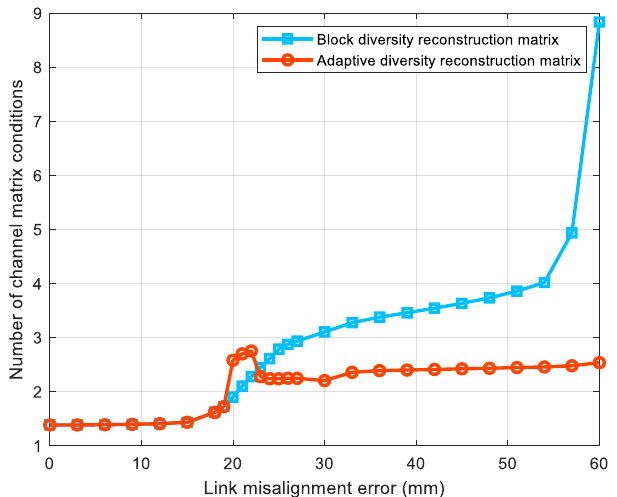
Figure 8. Condition number of H versus the link misalignment errors for adaptive and block diver- sity processing.